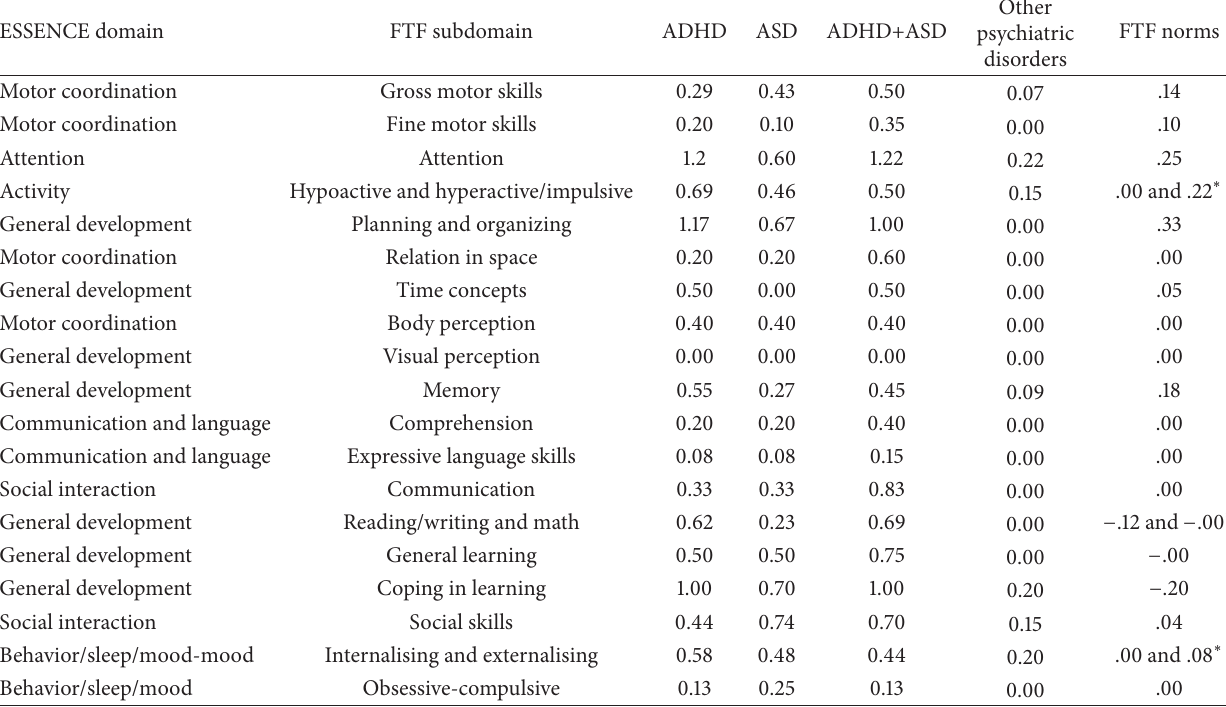
Table 2: Five to fifteen subdomain median